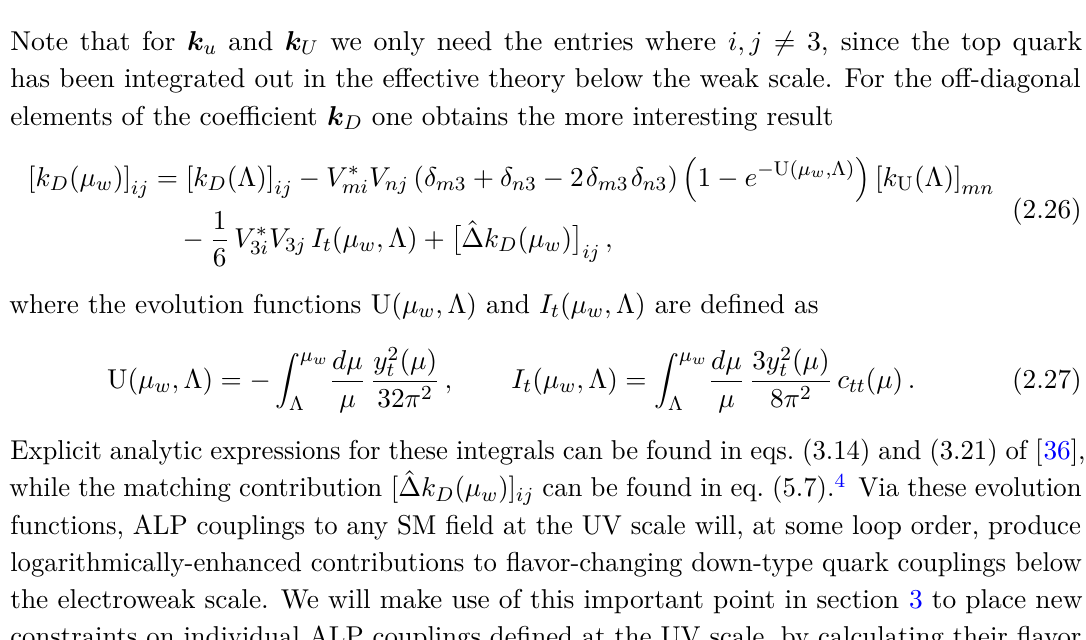
Figure 2 . Representative diagrams contributing to the flavor-changing ALP coupling in